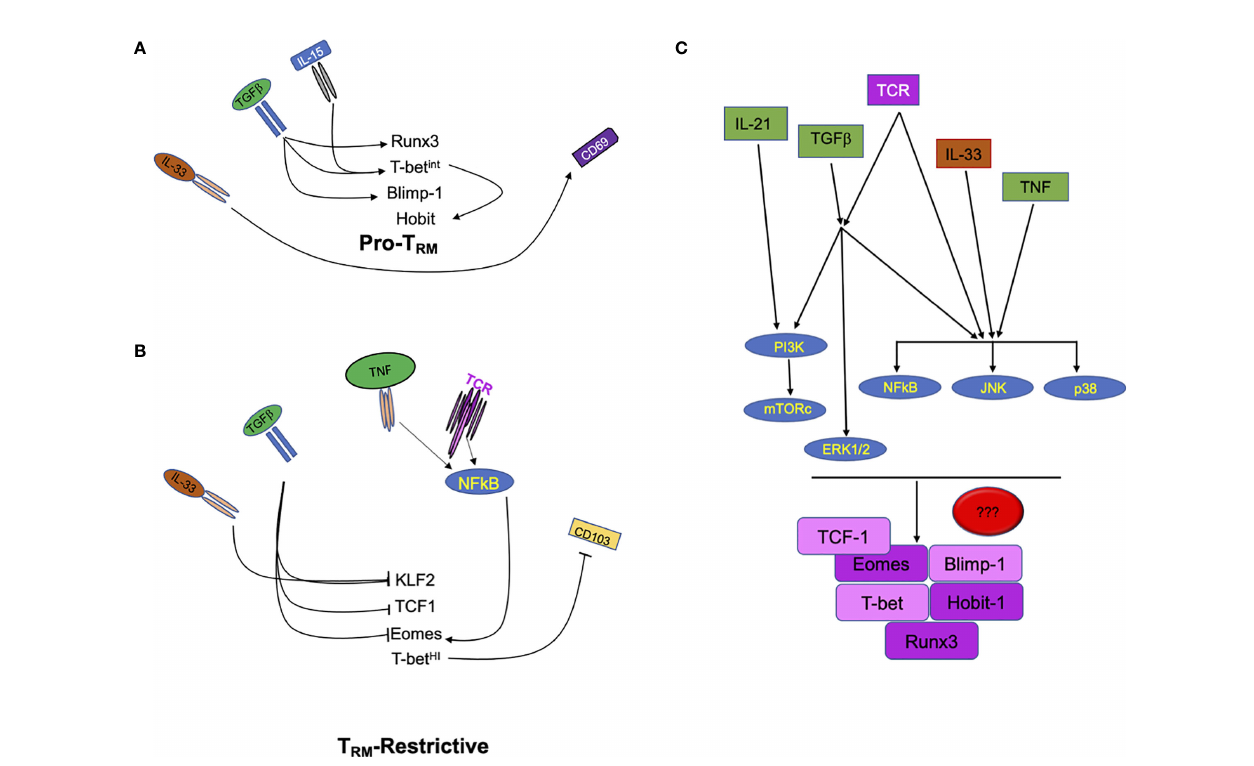
FIGURE 1 | Extracellular factors regulate multiple signals in CD8 T cells to drive or repress T RM development. (A) Schematic of signals including IL-33, TGF b , and IL-15 which promote the development of tissue resident T cell memory through the increase of transcription factors Runx3, Hobit, Blimp1, and the tuning of T-bet expression. (B) Tissue cytokines such as IL-33 and TGF b also inhibit transcription factors (KLF2, TCF1, and Eomes) that can restrict the development of CD8 T RM . In contrast, pro-in fl ammatory cytokine and antigenic/T cell receptor signals can modulate the expression of Eomes which can, then, interfere with CD8 T RM development. (C) Signaling crosstalk between pro-in fl ammatory, tissue and antigenic signals. PI3K, MAPKs (ERK, JNK and p38 MAPK) and NF k B are potential nodes where extracellular cues converge to tune CD8 T RM programming, differentiation and